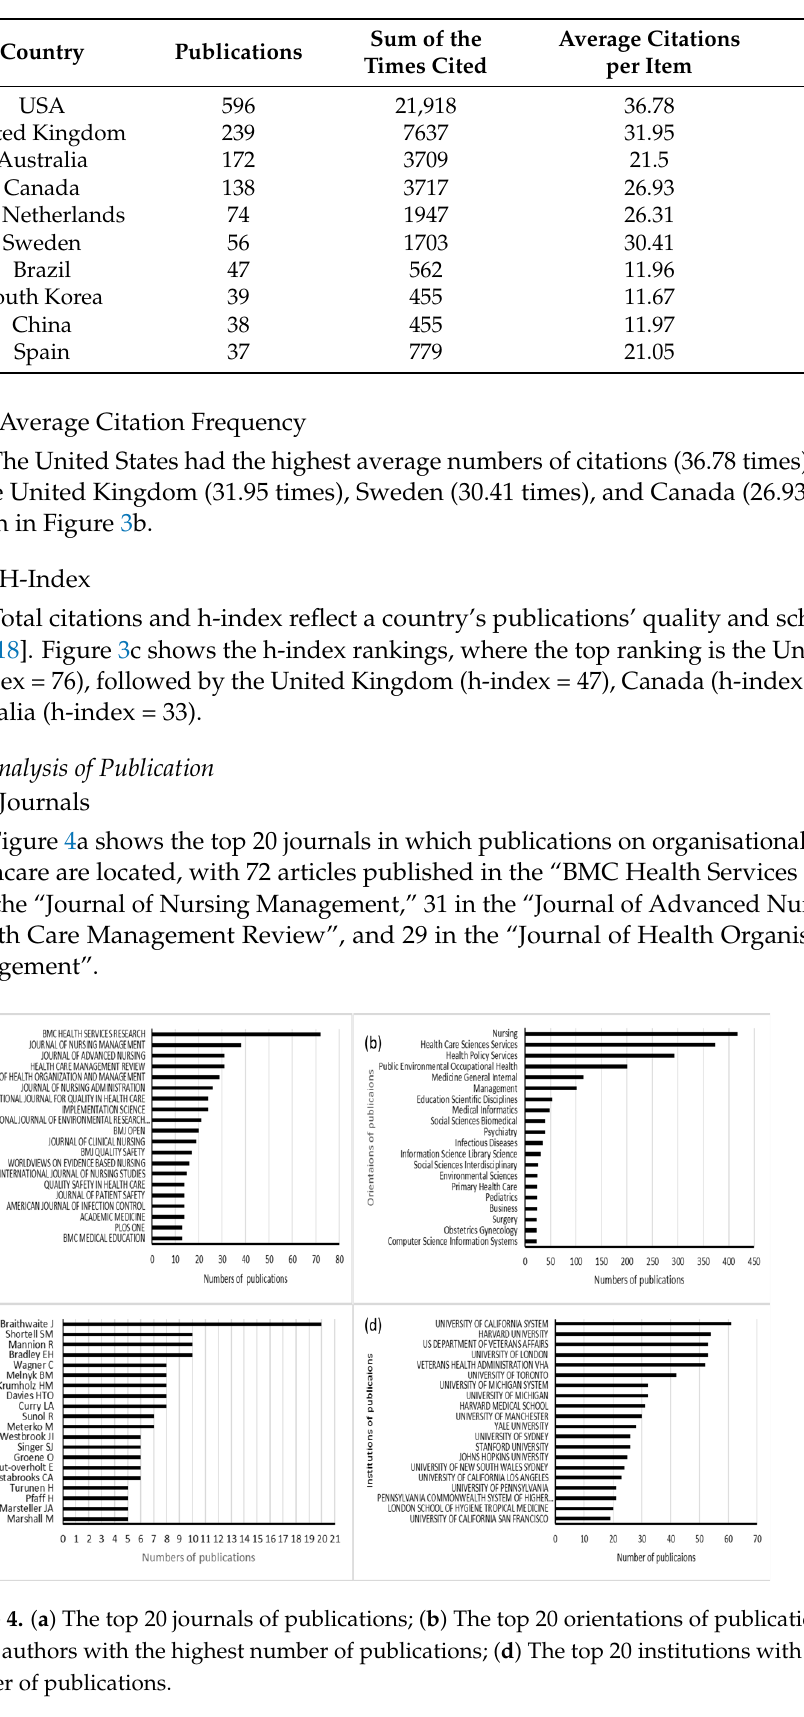
Table 1. The contributions in publications of countries.